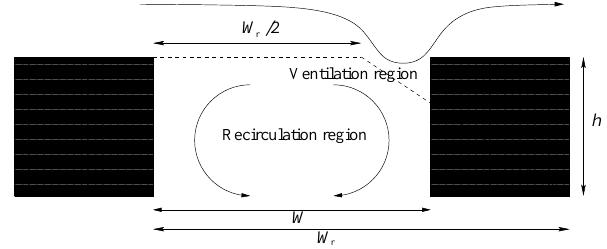
Figure 2. Intermediate case leading to a wake interference flow.